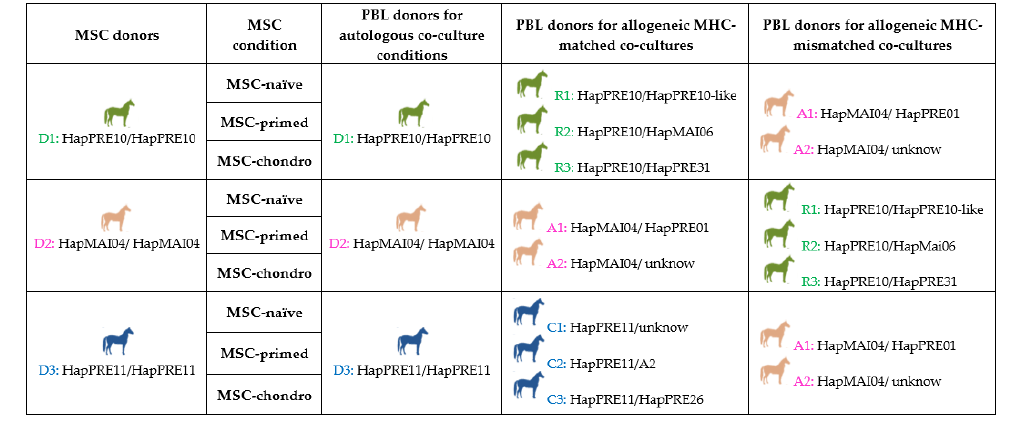
Figure 1. Study design showing mesenchymal stem cells (MSCs) and peripheral blood lymphocytes (PBLs) donors to establish autologous and allogeneic major histocompatibility complex (MHC)-matched and MHC-mismatched co-cultures, to study immunomodulatory capacity and immunogenic potential. MSCs were assayed unstimulated (MSC-naïve), primed with cytokines (MSC-primed) or chondrogenically differentiated (MSC-chondro).